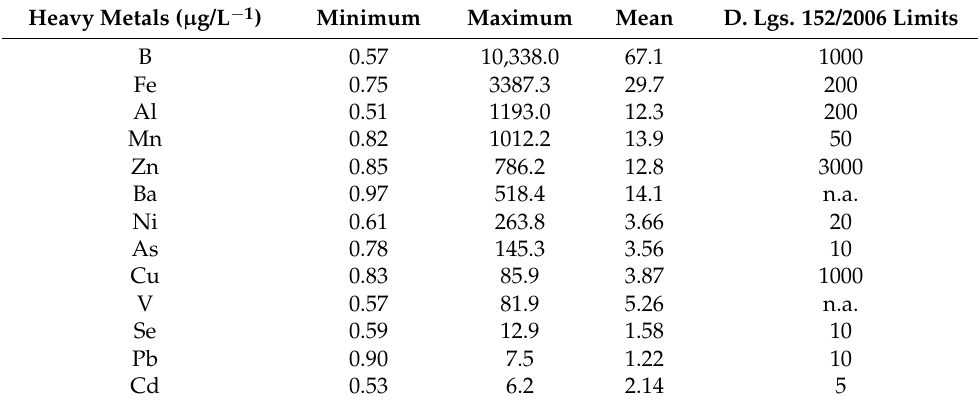
Table 2. Minimum, Maximum, and Mean concentrations of heavy metals in groundwater samples of Campania